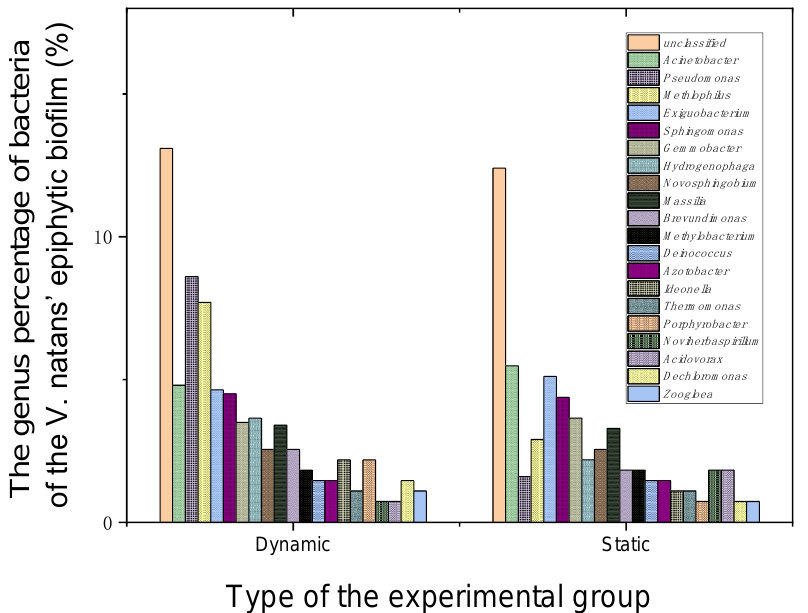
Figure 5. Effects of water flowrate of 35 cm · s –1 on the bacteria of the V. natans ’ epiphytic biofilm after 60 days of cultivation.